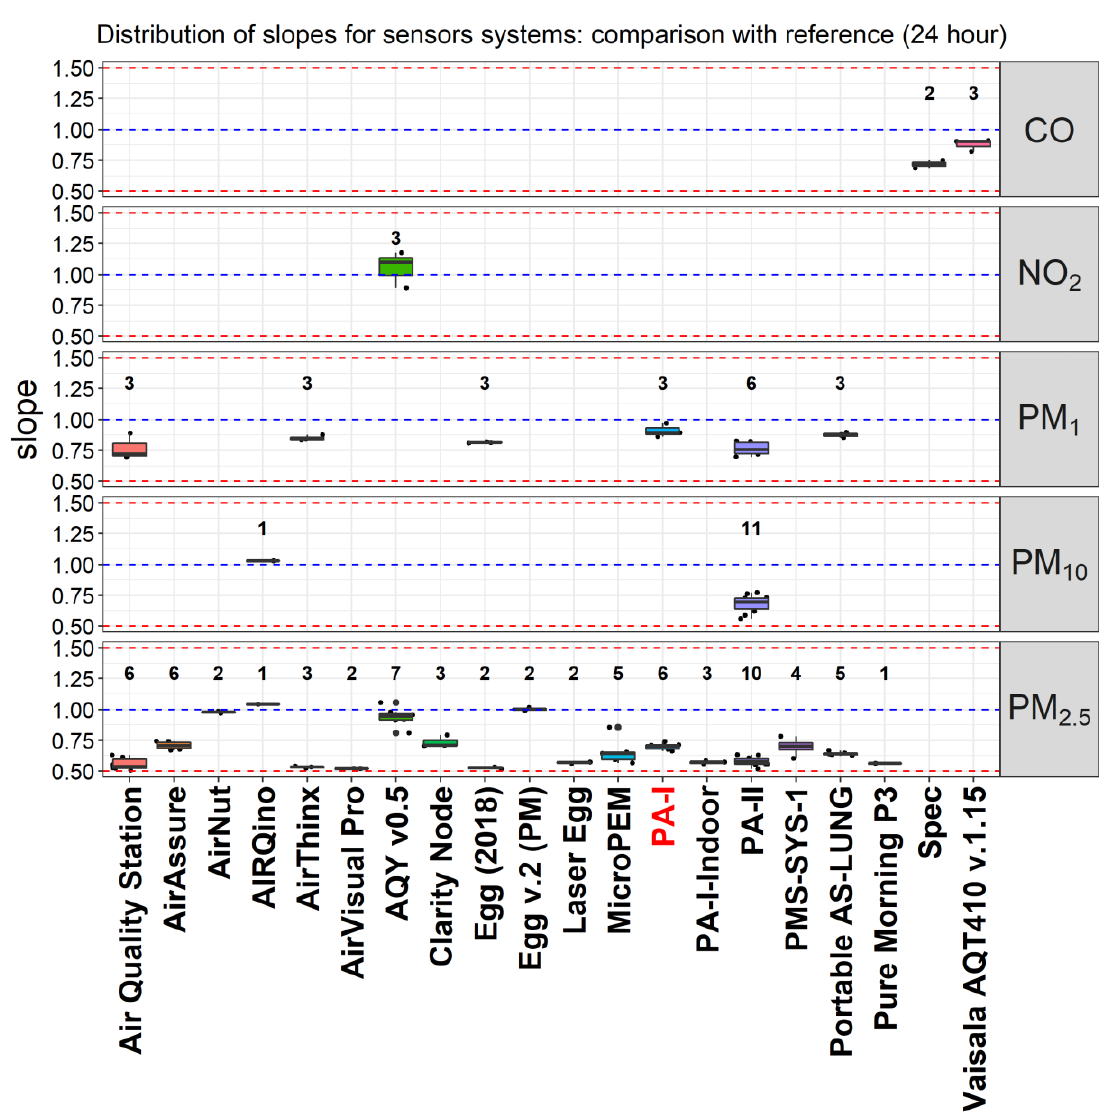
Figure A10. Distribution of slopes from the comparison of SSys against the reference. Only records with R 2 > 0.7 and 0.5 < slope < 1.5 are shown. Records were averaged over a time-scale of daily data. Numbers in blue and black indicate the number of open source and black box records, respectively. Names of “living” and “non-living” sensors are indicated by black and red labels on the x-axis, respectively.